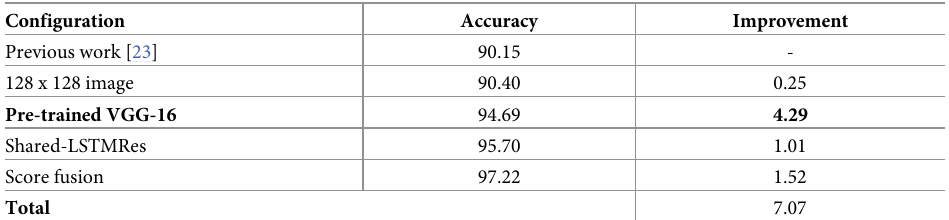
Table 2. Average accuracy gain (%)with new